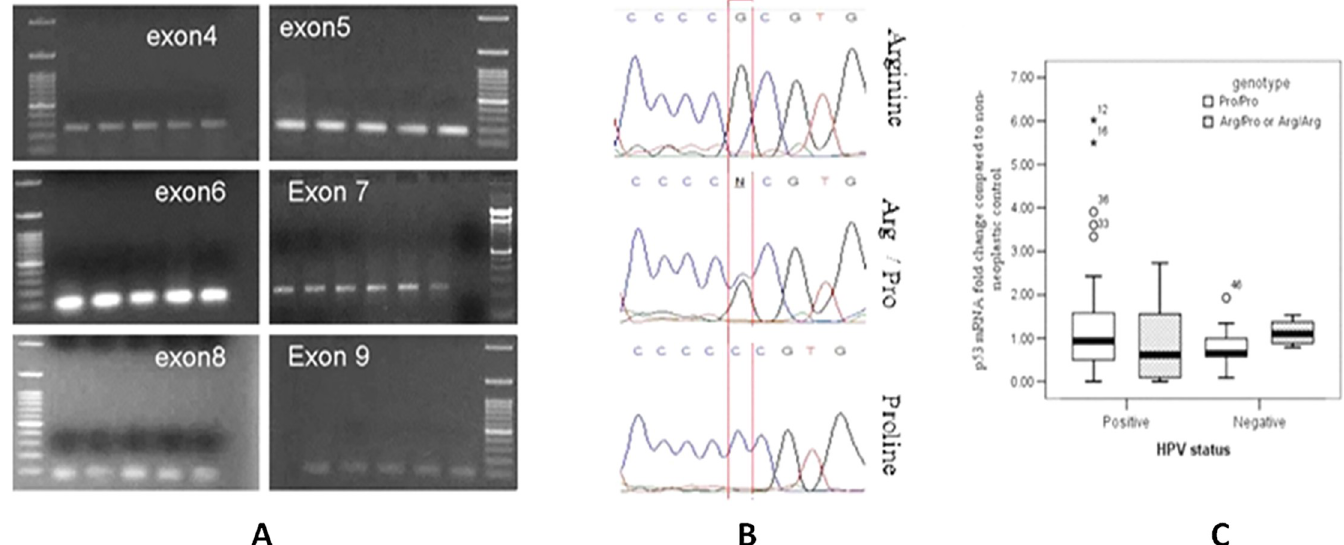
Fig 4. [A] Representative agarose gel electrophoresis photograph showing the PCR amplification of exon 4,5,6,7,8 and 9 of p53 gene for mutation analysis in cervical cancer cases. [B] Representative electrophoregrams showing the presence of Arg/Arg, Arg/Pro heterozygous and Pro/Pro genotype based on p53 exon 4 sequencing analysis in the studied Cervical cancer patient population cohort, [C] Box-plot analysis showing the difference in pattern of p53 mRNA expression fold change profile in Arg/Pro heterozygous or Arg/Arg homozygous genotype compared to the Pro/Pro genotype in HPV+ve and HPV-ve cases, thereby signifying the importance of rs1042522 polymorphism in the northeast Indian population.